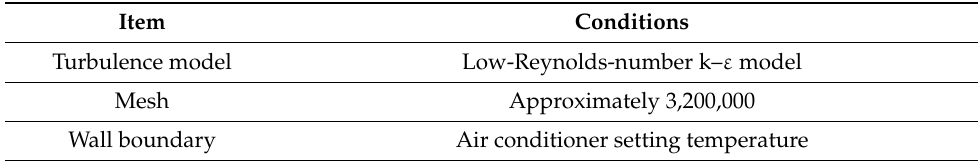
Table 4. CFD analysis